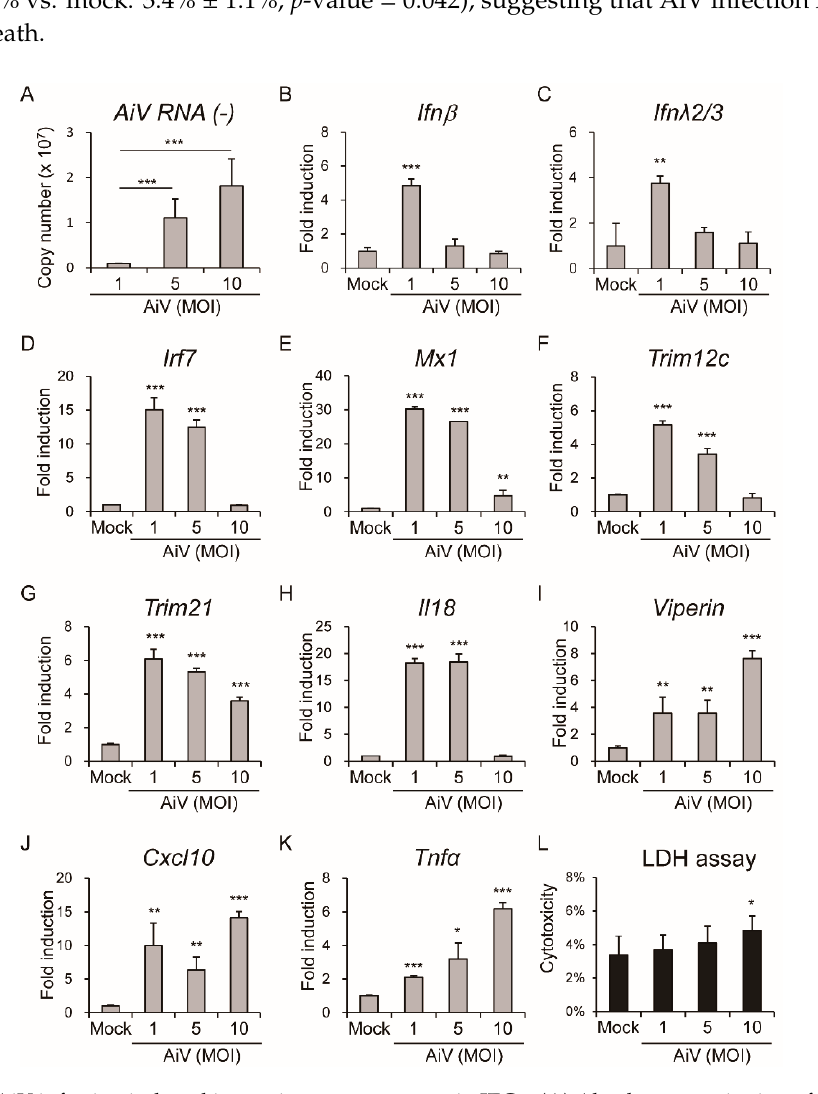
Figure 5. AiV infection induced innate immune response in IECs. ( A ) Absolute quantitation of the viral genome copy number of AiV RNA (-) using RT-PCR with AiV VP1 (-) specific primers, in IECs (1 × 10 6 ) with AiV infection at the MOI of 1, 5, and 10 for 24 hpi. ( B – L ) IECs infected as described above, and ( B – K ) qPCR analysis of mRNA levels of Ifn β , Ifn λ 2 / 3, Irf7, Mx1, Trim12c, Trim21, Il18, Viperin, Cxcl10, and Tnf α genes normalized to that of Gapdh . Fold induction compared with mock. ( L ) LDH release measurement performed and measured as AiV cytotoxicity of (%). Data compared with uninfected mock showed as means ± SD ( n = 3). Student’s t -test *, p < 0.05; **, p < 0.01; ***, p < 0.001.